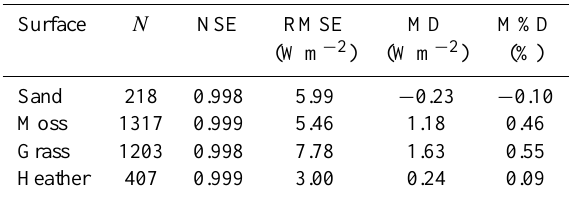
Table 1. Model performance of R ns simulations.